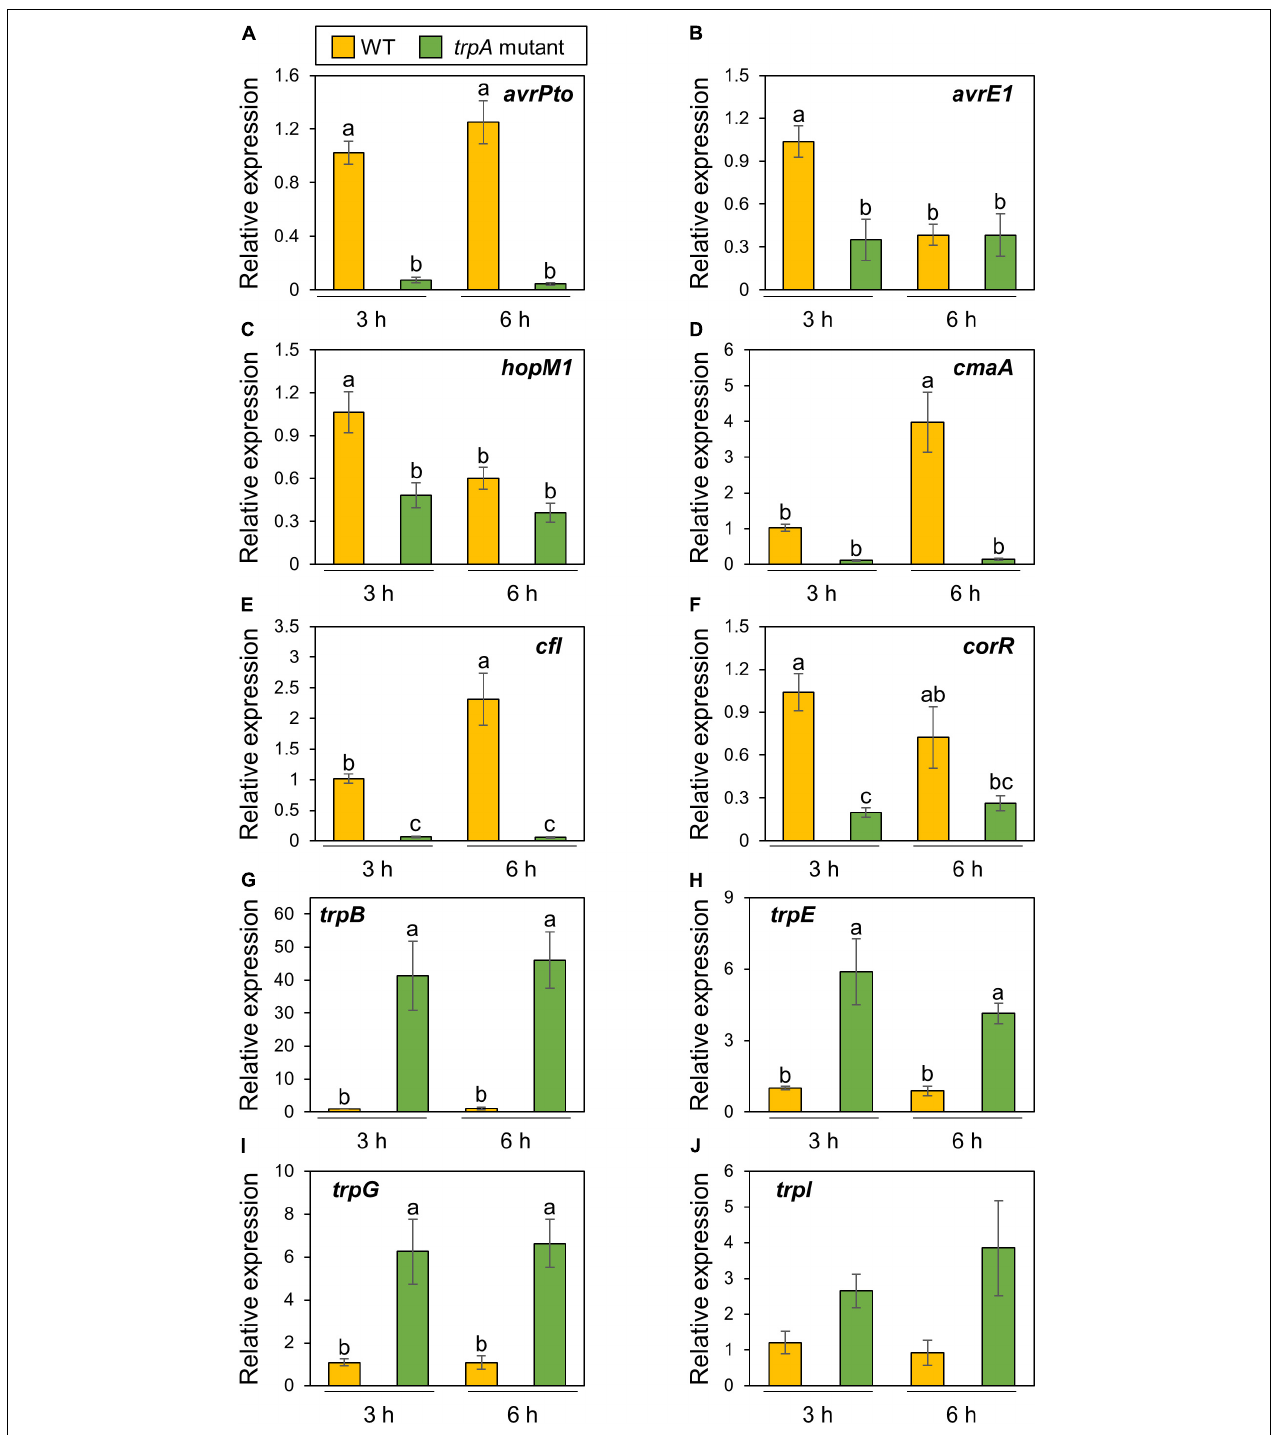
FIGURE 5 | Expression profiles of bacterial virulence genes and tryptophan biosynthesis genes during Pseudomonas cannabina pv. alisalnesis KB211 WT and trpA mutant infection. Cabbage plants were syringe-inoculated with 5 × 10 7 CFU/ml of WT and the trpA mutant and total RNAs were collected 3 and 6 h after inoculation. Expression profiles of type three effector (T3Es) genes [including avrPto (A) , avrE1 (B) , and hopM1 (C) ] and COR biosynthesis related genes [including cmaA (D) , cfl (E) , and corR (F) ] were investigated. Additionally, expression profiles of tryptophan biosynthesis related genes [including trpB (G) , trpE (H) , trpG (I) , and trpI (J) ], were also investigated. Total RNA was extracted for use in real-time quantitative reverse transcription-polymerase chain reaction (RT-qPCR) with gene-specific primer sets ( Supplementary Table 2 ). Expression was normalized using oprE and recA . Vertical bars indicate the standard error for at least six biological replicates. Different letters indicate a significant difference among treatments based on a Tukey’s HSD test ( p < 0.05).